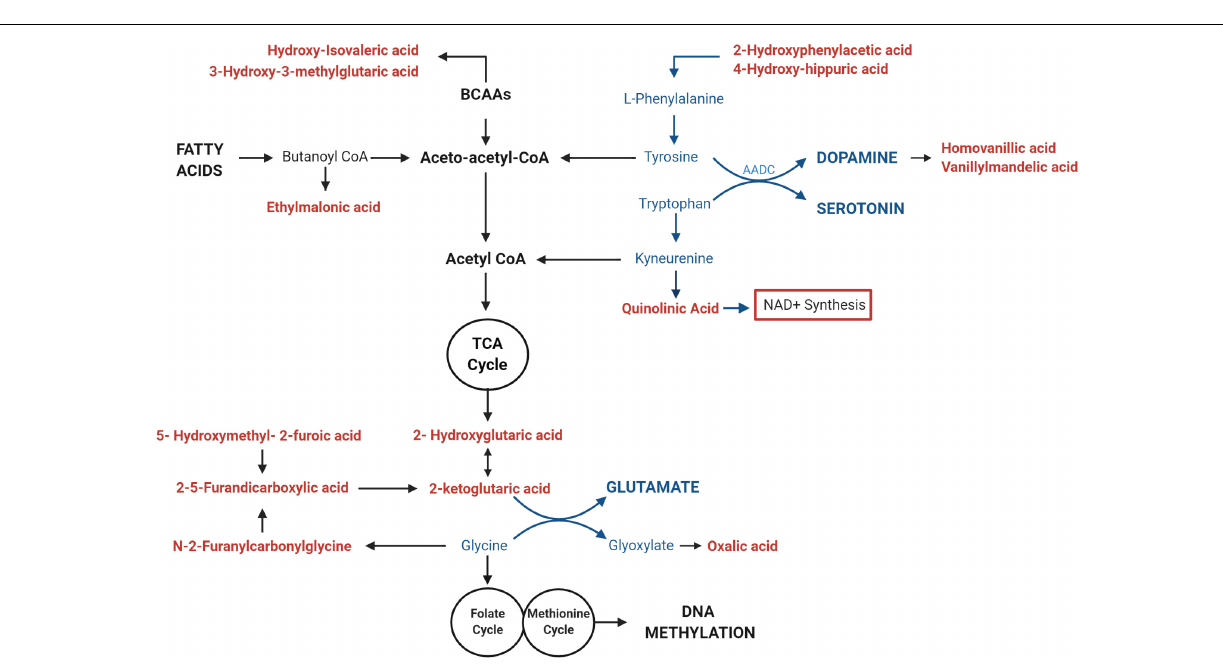
FIGURE 5 | Urinary metabolite, 3-hydroxy-3-methylglutaric acid (3-H-3-MGA), correlates with PGC-1 α methylation and mitochondrial DNA (mtDNA) copy number. Normal linear regression analysis shows that (A) DNA methylation at PGC-1 α CpG#1 correlates with 3-H-3-MGA levels, RSQ = 0,2163, Spearman Rho = 0.386, p = 0,043 and (B) mtDNA copy number correlates with 3-H-3-MGA, RSQ = 0,2282, Spearman Rho = 0.355, p = 0,004; (ASD n = 20, control n = 13).